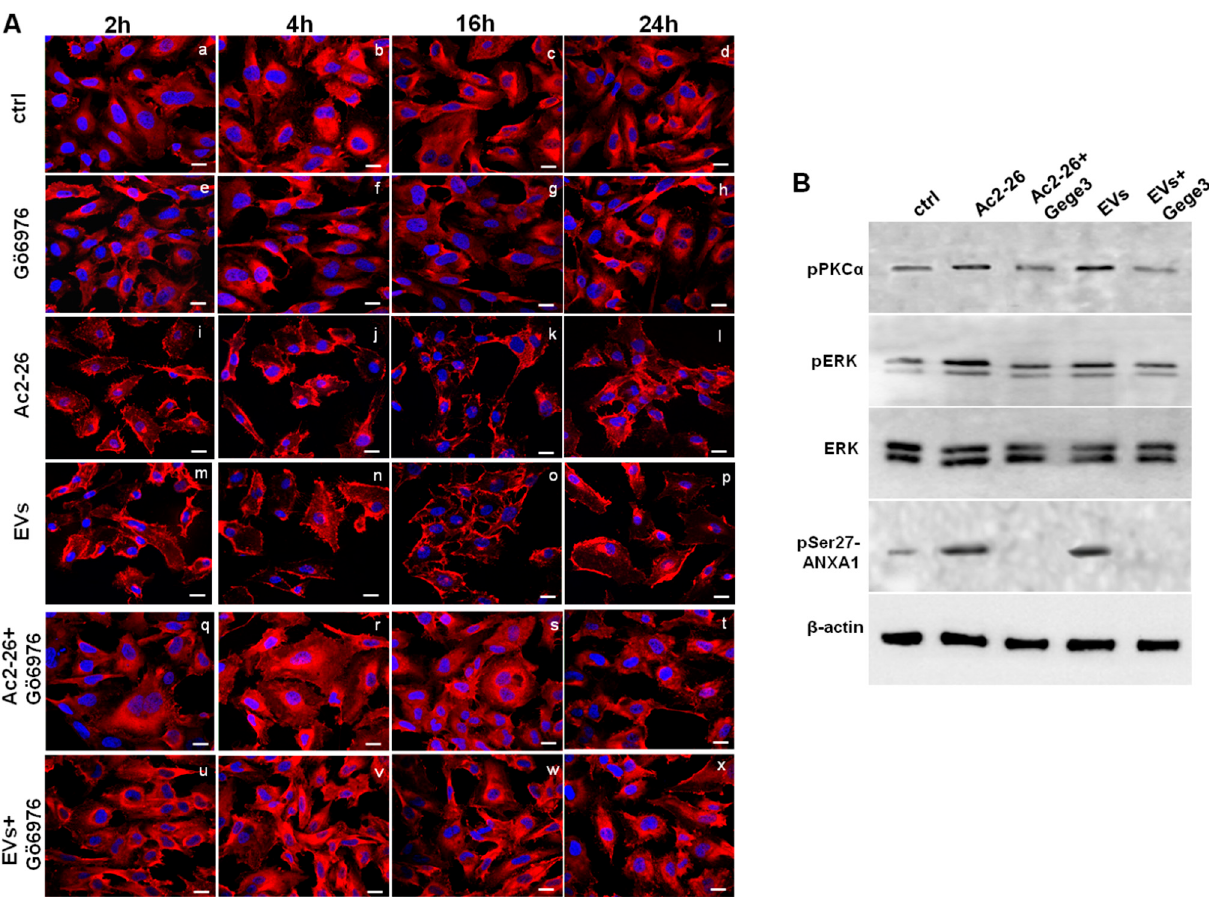
Figure 6. The interference of Gege3 on Ac2-26 and PC EVs affects HUVEC cells. ( A ) Immunofluorescence analysis to detect ANXA1 intracellular localization after treatments with Gö6976 (panels e – h ), Ac2-26 (panels i – l ), EVs (panels m – p ), Ac2-26+Gö6976 (panels q – t ) and EVs+Gö6976 (panels u – x ) for 2, 4, 16 and 24 h, not treated cells (panels a – d ). Magnification 63 × 1.4 NA. Bar = 100 µ m. The data are representative of three independent experiments with similar results. ( B ) Western blotting for pPKC α , pERK, ERK, pSer27-ANXA1 normalized with β -actin on HUVEC cells treated with Ac2-26 1 µ M, Ac2-26+Gege3, EVs and EVs+Gege3 for 15 min. Cropped blots from full-length gels are representative of three independent experiments with similar results.